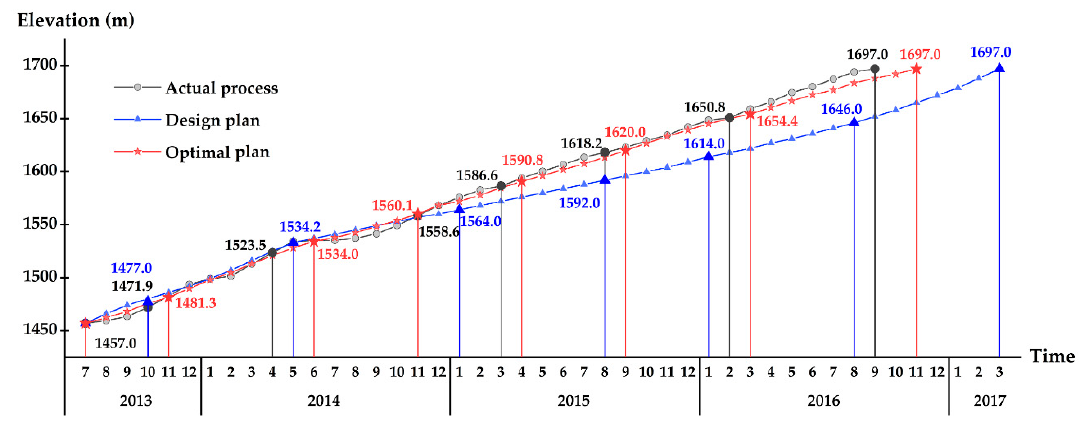
Figure 17. Comparison of filling elevation.